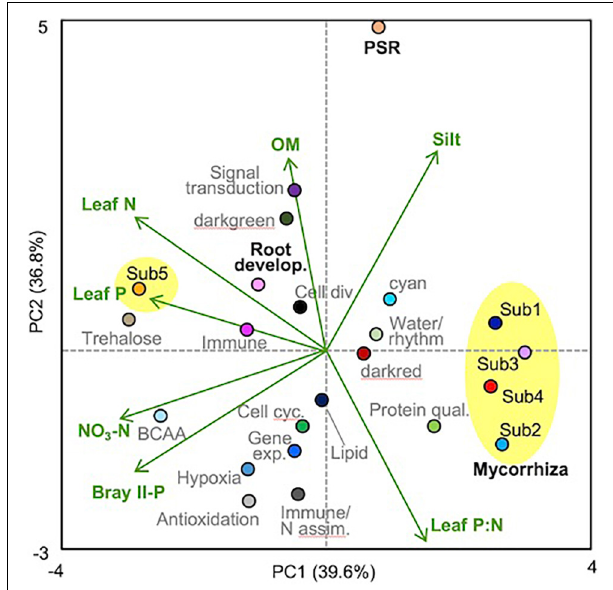
FIGURE 3 | PCA biplot of module-factor correlations. The plot was drawn based on the correlation coefficients obtained by pairwise correlation analysis between the soil/plant factors and the module eigengenes ( Supplementary Table 14 ), in which the factors leaf N, P, and P:N, Bray II-P, NO 3 -N, organic matter (OM), and silt% were selected by taking into account multicollinearity. The submodules of the mycorrhizal module were circled with yellow. Module names (functions) and colors are listed in Table 1 , and the mycorrhizal (submodules), PSR, and root development modules were indicated with bold black letters.